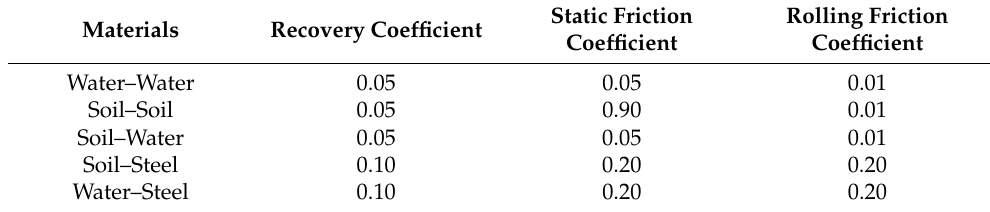
Table 3. Contact parameters between